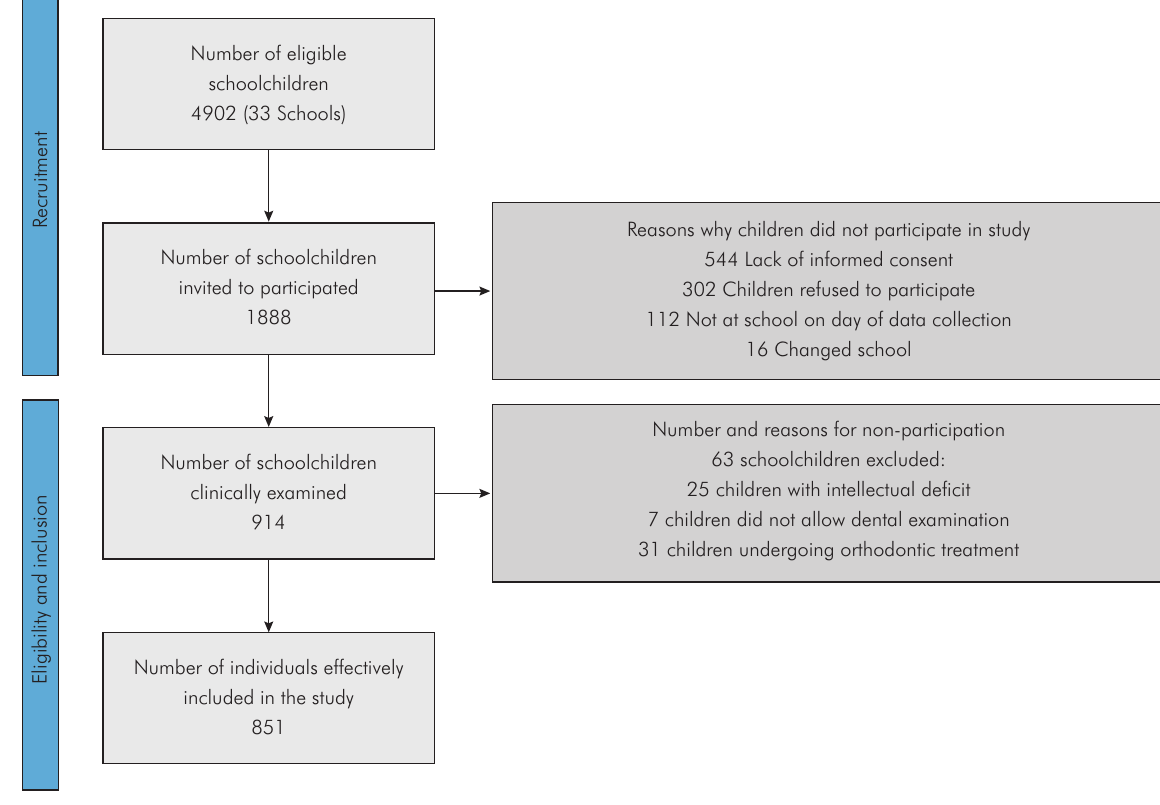
Figure 1. Flowchart of participant selection